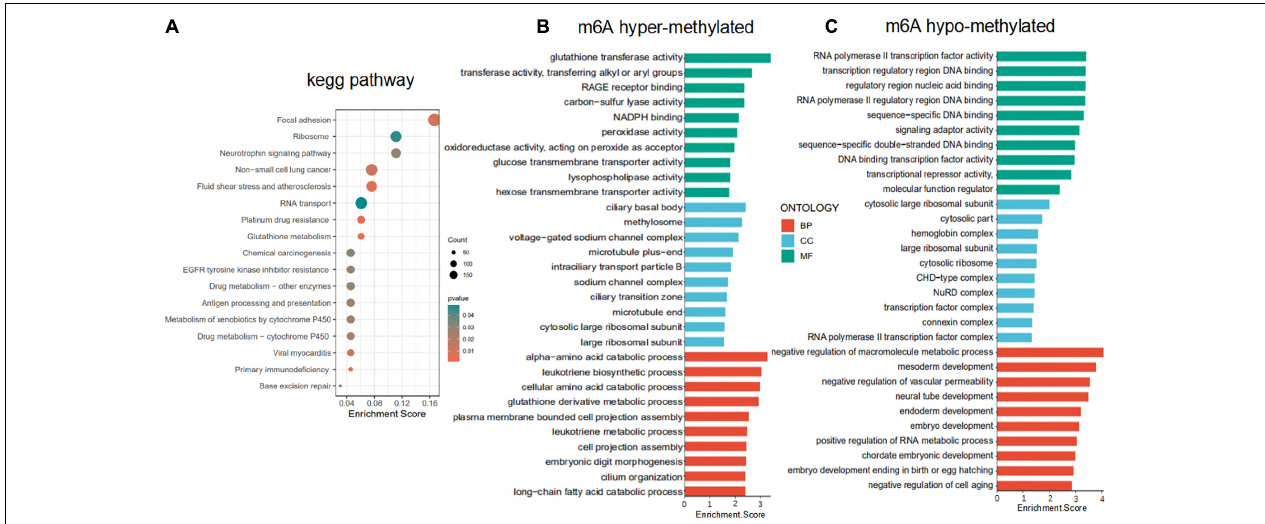
FIGURE 3 | Functional enrichment of differentially m6A methylated mRNAs. (A) KEGG pathway enrichment analysis of hypo- and hypermethylated mRNAs. (B,C) Gene ontology (GO) enrichment analysis of the m6A hypermethylated and hypomethylated